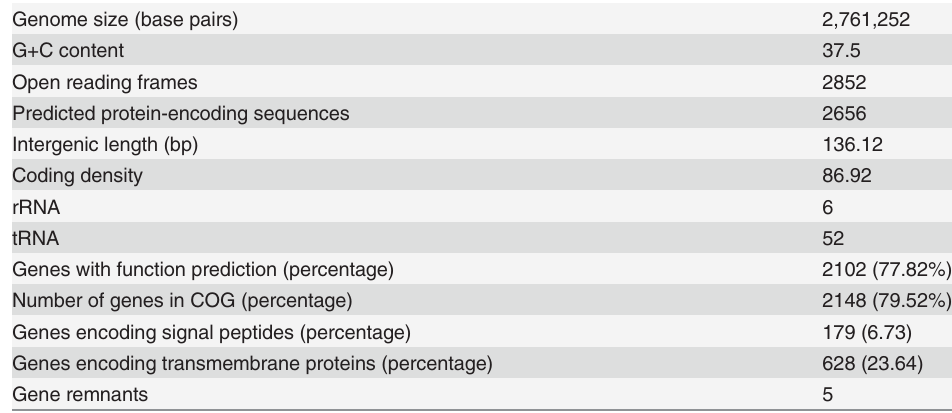
Table 1. General genomic features of Tepidanaerobacter acetatoxydans strain